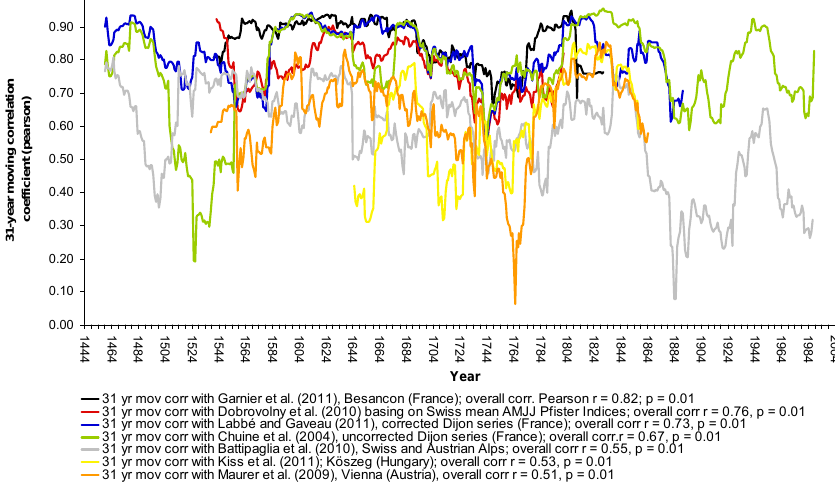
Fig. 4. Temperature reconstruction based on the homogenised Swiss GHD series covering the period from 1444–2011. A Grape-Temp-18-5 12.12.2012